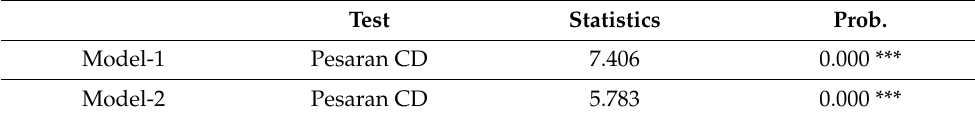
Table 6. Outcomes of CD